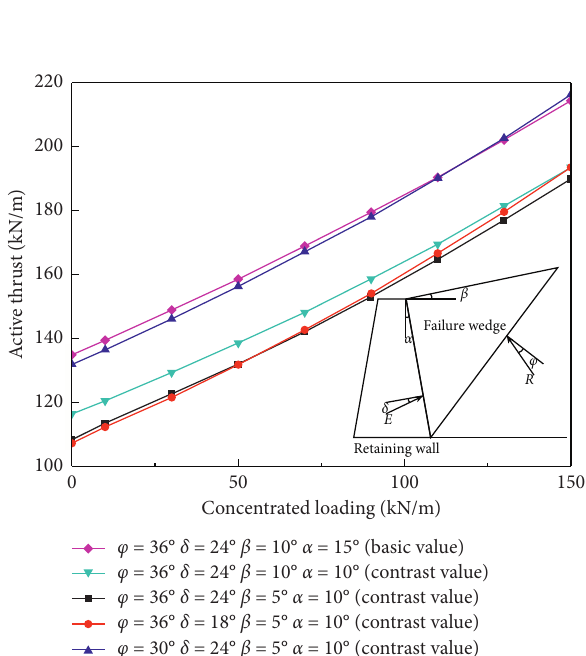
Figure 7: Variations of the active thrust E